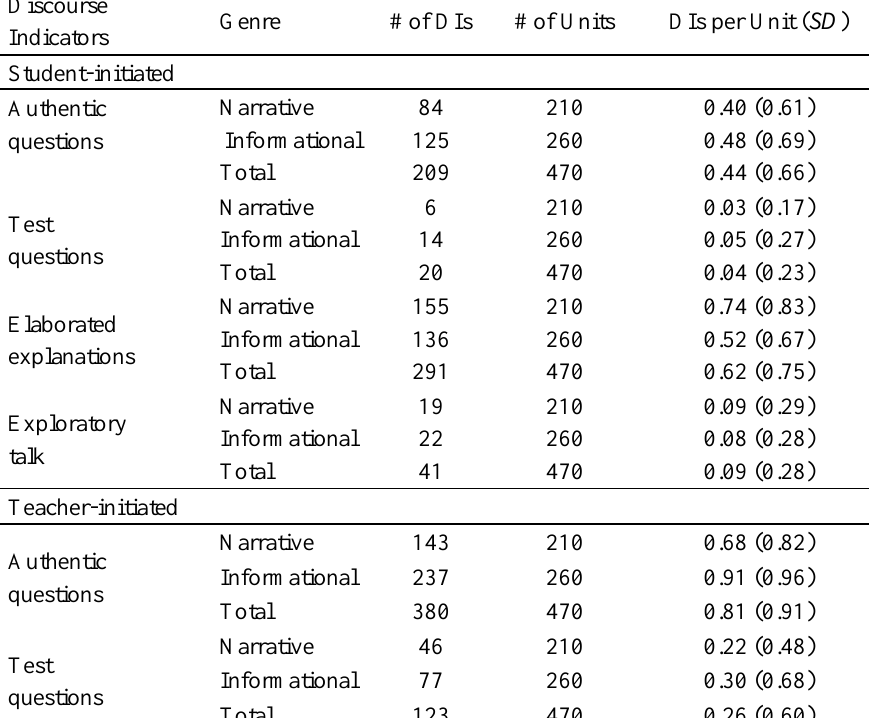
Student- and Teacher-initiated Discourse Indicators by